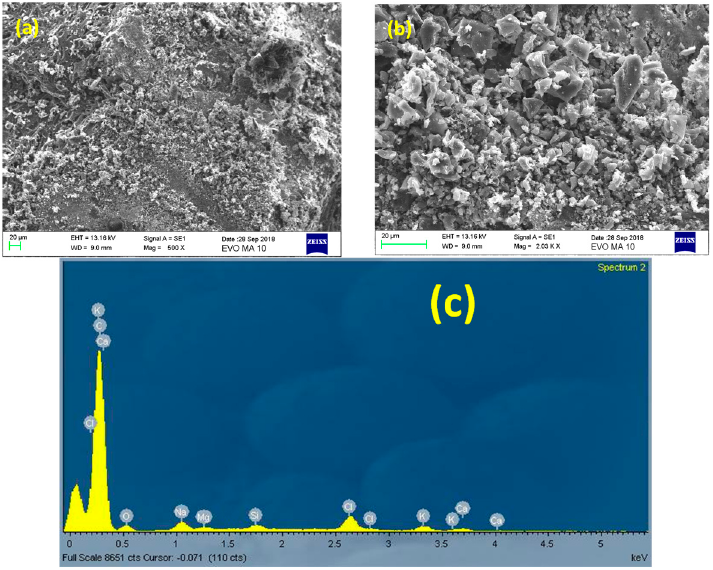
Figure 4. SEM images ( a ) and ( b ) and EDS analysis ( c ) of the biochar.